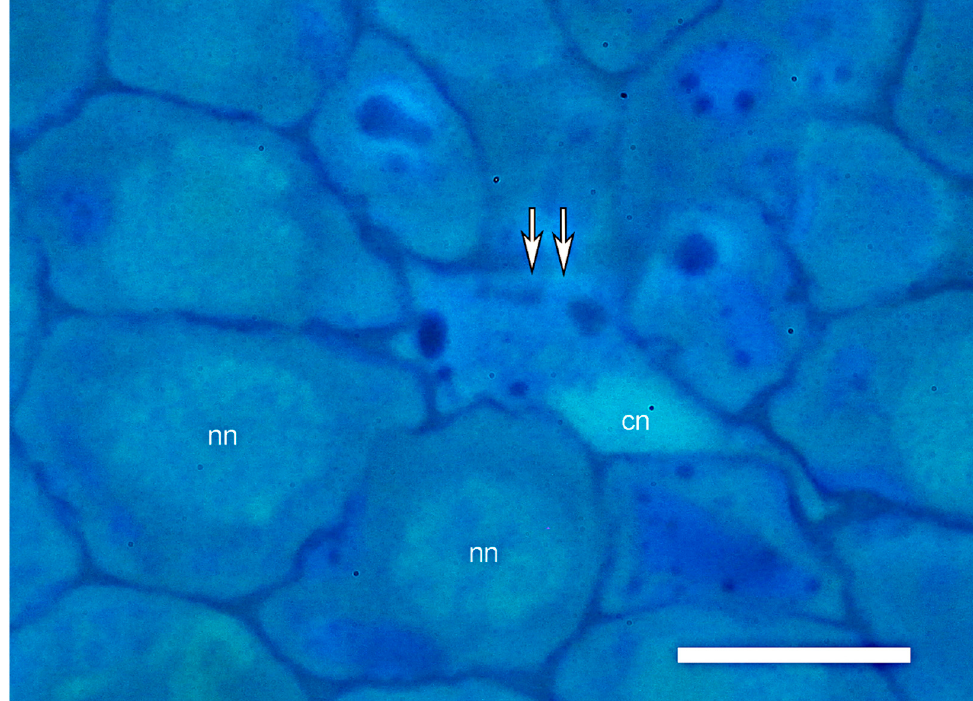
Figure 7. Condensed chromatin in the nucleus of a collapsed LMX element. Highly magnified, DAPI-stained transverse section viewed via fluorescent light microscopy reveals that chromatin in nuclei of a collapsing LMX element (double arrows) is highly condensed compared to nuclei of surrounding cells. nn, normal nucleus; cn, condensed nucleus. Scale bar = 10 µm.